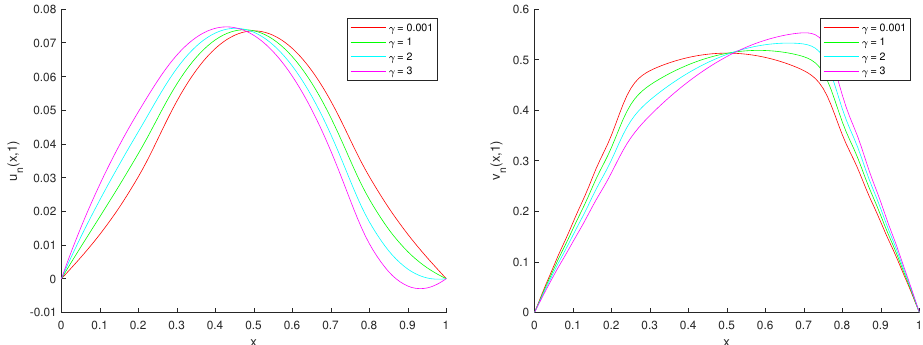
Figure 3. Example 2: displacement and velocity of the elastic solid for different values of parameter γ